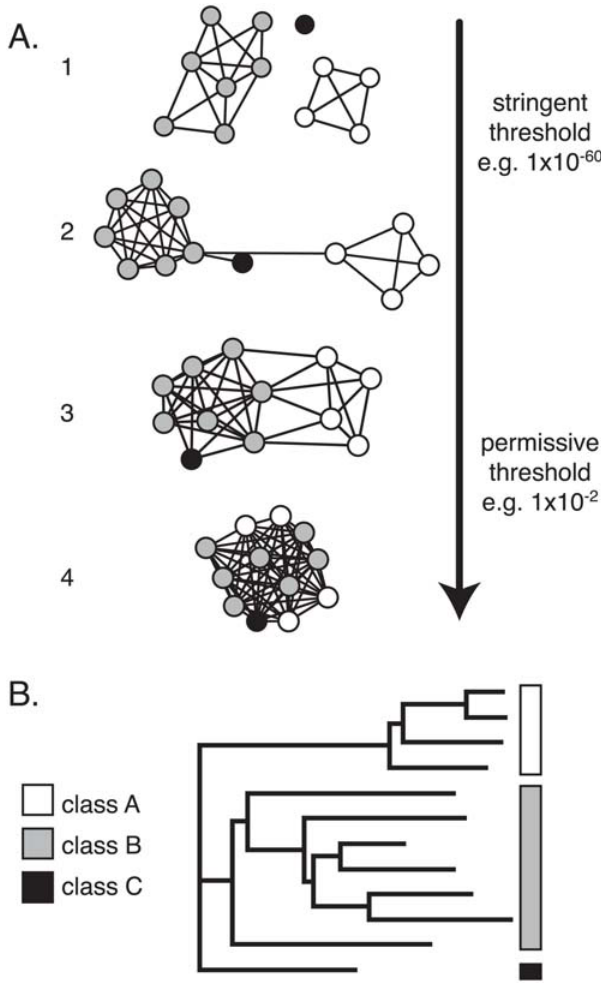
Figure 1. Sequence similarity network topology changes in a predictable way with the stringency of the threshold. A. Thresholded sequence similarity networks represent sequences as nodes (circles) and all pairwise sequence relationships (alignments) better than a threshold as edges (lines). The same network, depicting three simulated protein classes, is shown here at four different thresholds. At stringent thresholds, the sequences break up into disconnected groups; within each group the sequences are highly similar. The relative positioning of disconnected groups has no meaning, while the lengths of connecting edges tend to correlate with the relative dissimilarities of each pair of sequences. As the threshold is relaxed and edges associated with less significant relationships are added to the network, groups merge together and eventually become completely interconnected. B. Simulated dendro- gram for a sequence set that might give rise to the network in A.